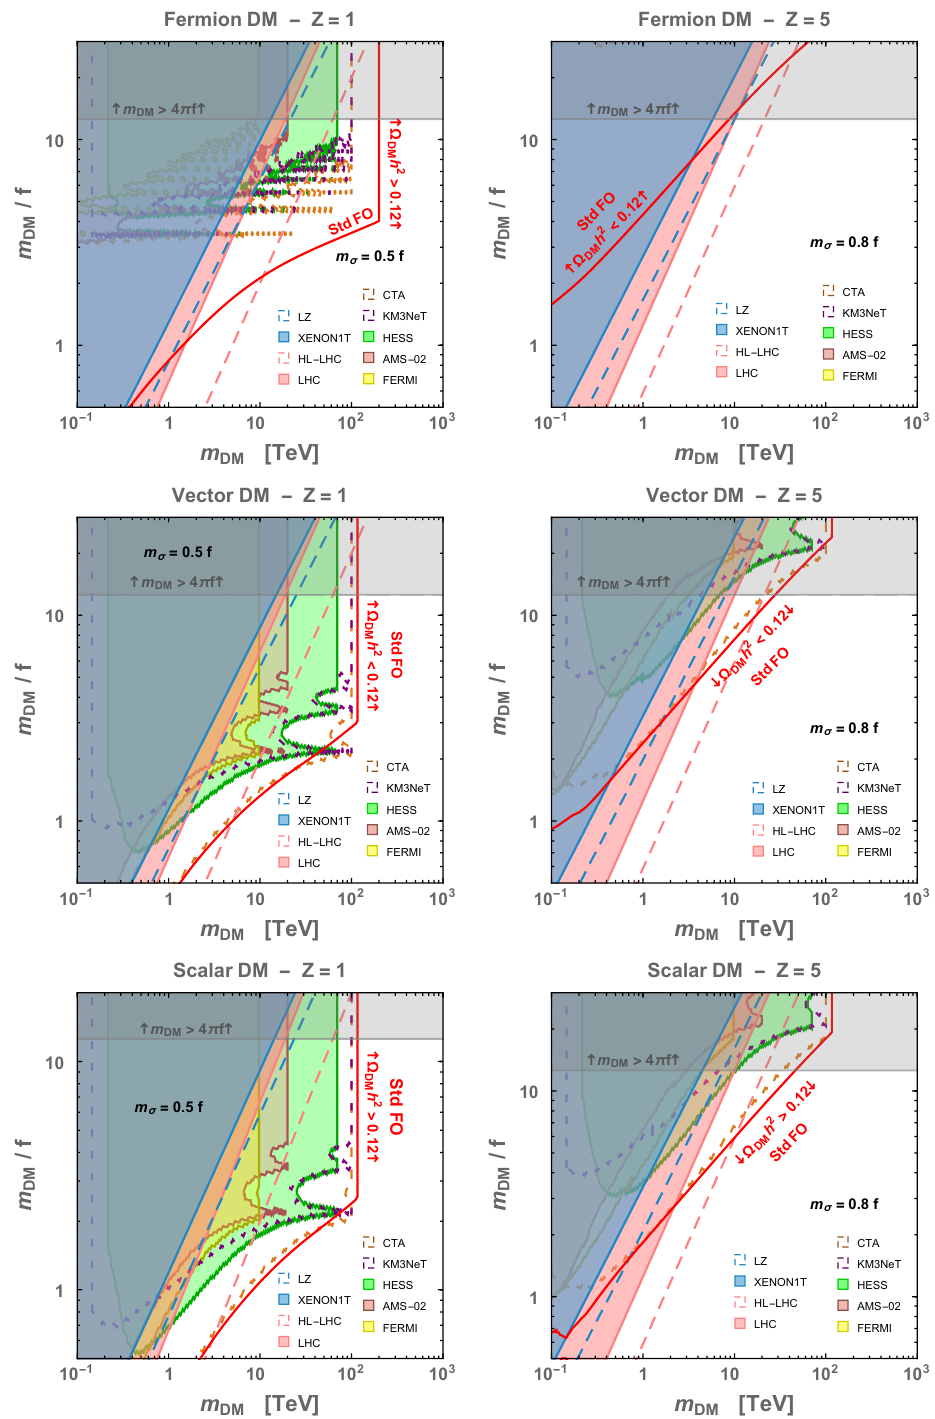
Figure 13 . Dilaton-mediated DM in the standard freeze-out case. We display DM as a fermion ( top ), vector ( middle ) and scalar ( bottom ) resonance of the strong sector, cf. section 3.1. Lines and shadings as in figure 3. In the fermionic case, the DM annihilation cross-section is p-wave, cf. eq. (3.18), so that the indirect-detection constraints are suppressed compared to the scalar and vector